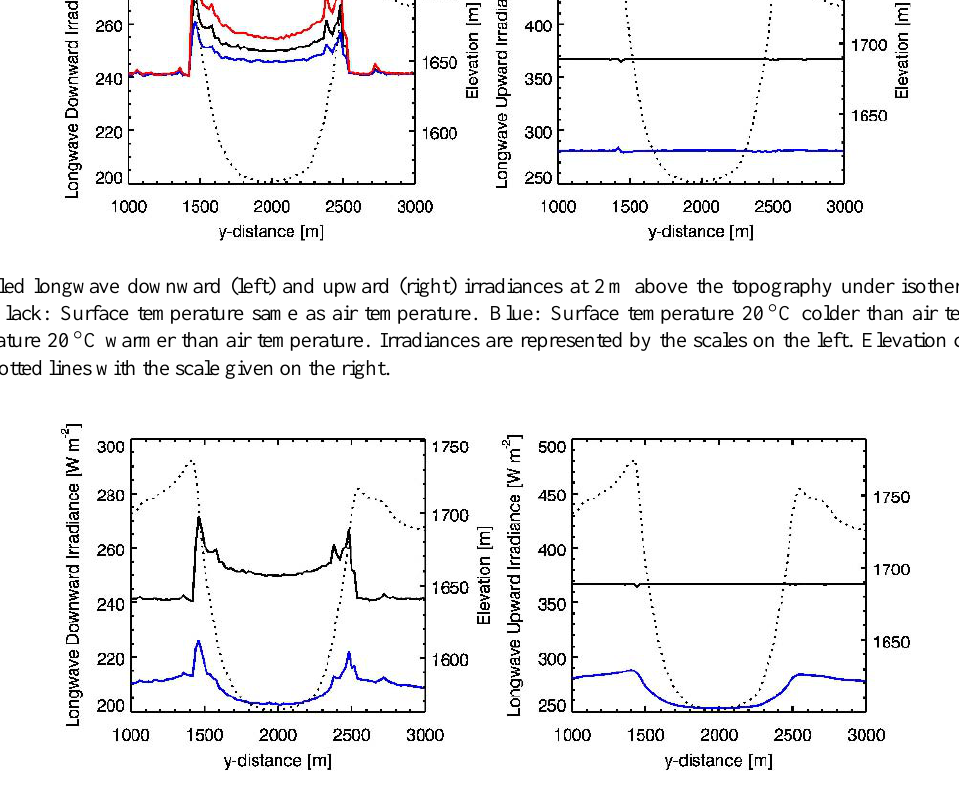
Fig. 12. Modeled longwave downward (left) and upward (right) irradiances 2m above the topography under different atmospheric stratifi- cations, isothermal (black) and stable (5 ◦ C / 100m, blue). The surface temperature was set to the temperature of the adjacent air. Irradiance values are shown on the left axes, while elevation values for the terrain cross section (thin dotted line) are shown on the